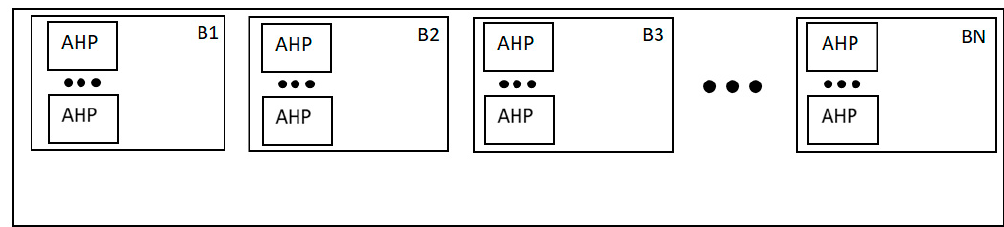
Figure 12. Reference system layout DHC system layout: reversible air-source heat pump (AHP), buildings (B1, B2, B3, …, BN).